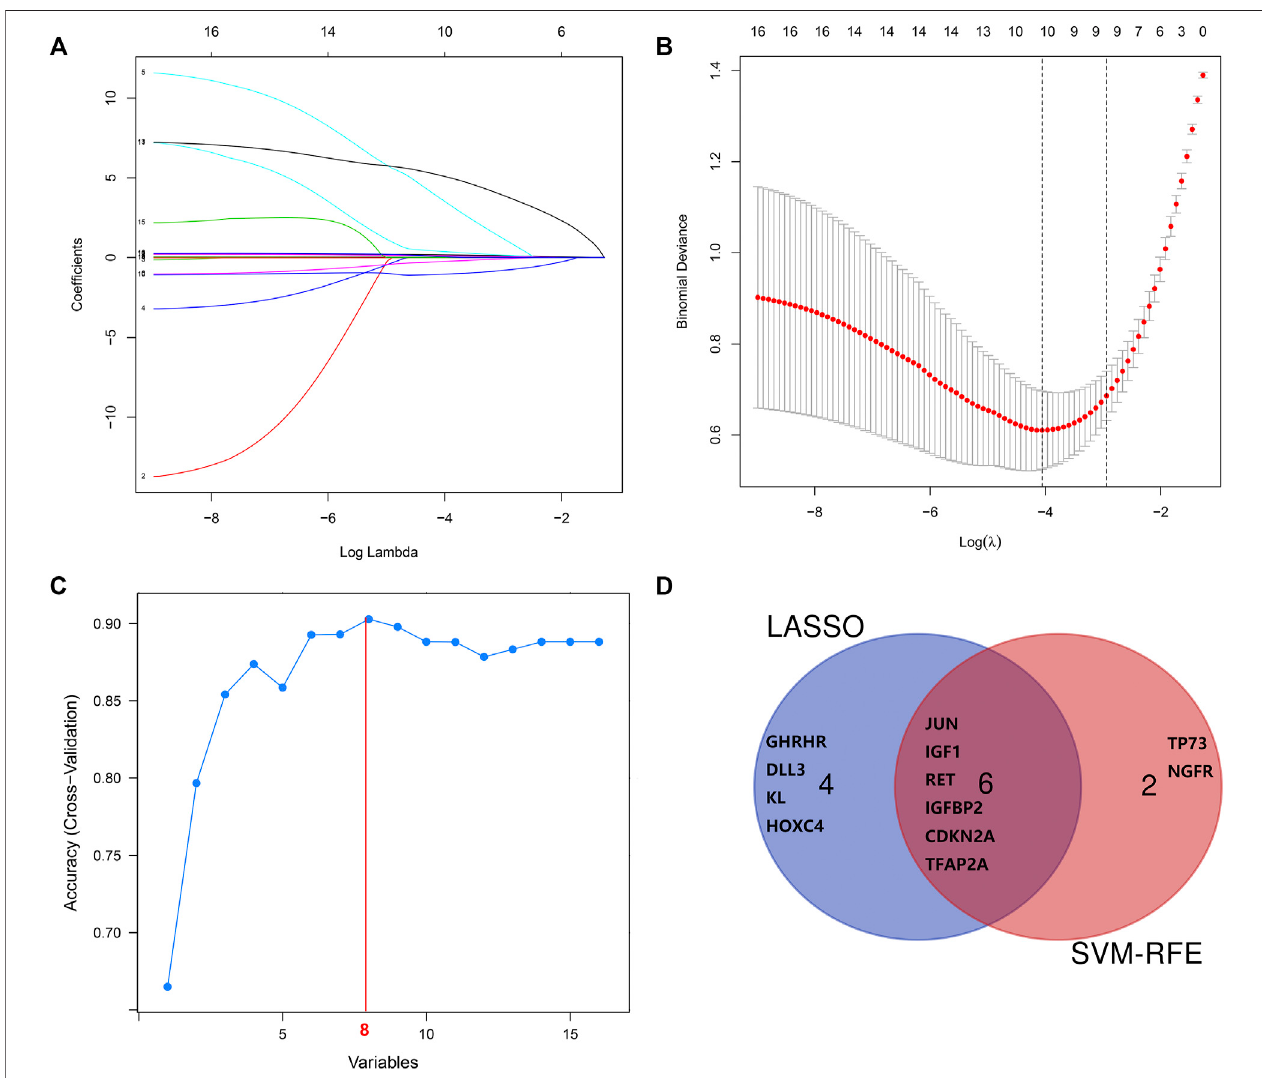
FIGURE 7 | Screening and veri fi cation of diagnostic markers. (A,B) Least absolute shrinkage and selection operator (LASSO) logistic regression algorithm to screen diagnostic markers. (C) Support vector machine-recursive feature elimination (SVM-RFE) algorithm to screen diagnostic markers. (D) Venn diagram demonstrates the intersection of diagnostic markers obtained by the two